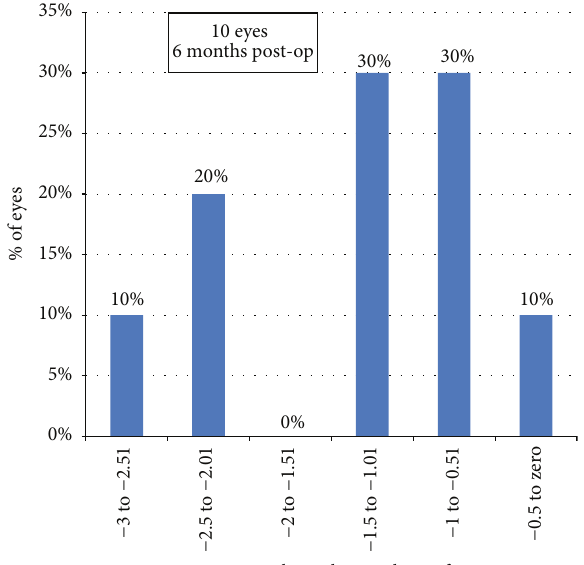
Figure 4: Predictability of spherical equivalent correction 6 m postoperatively.